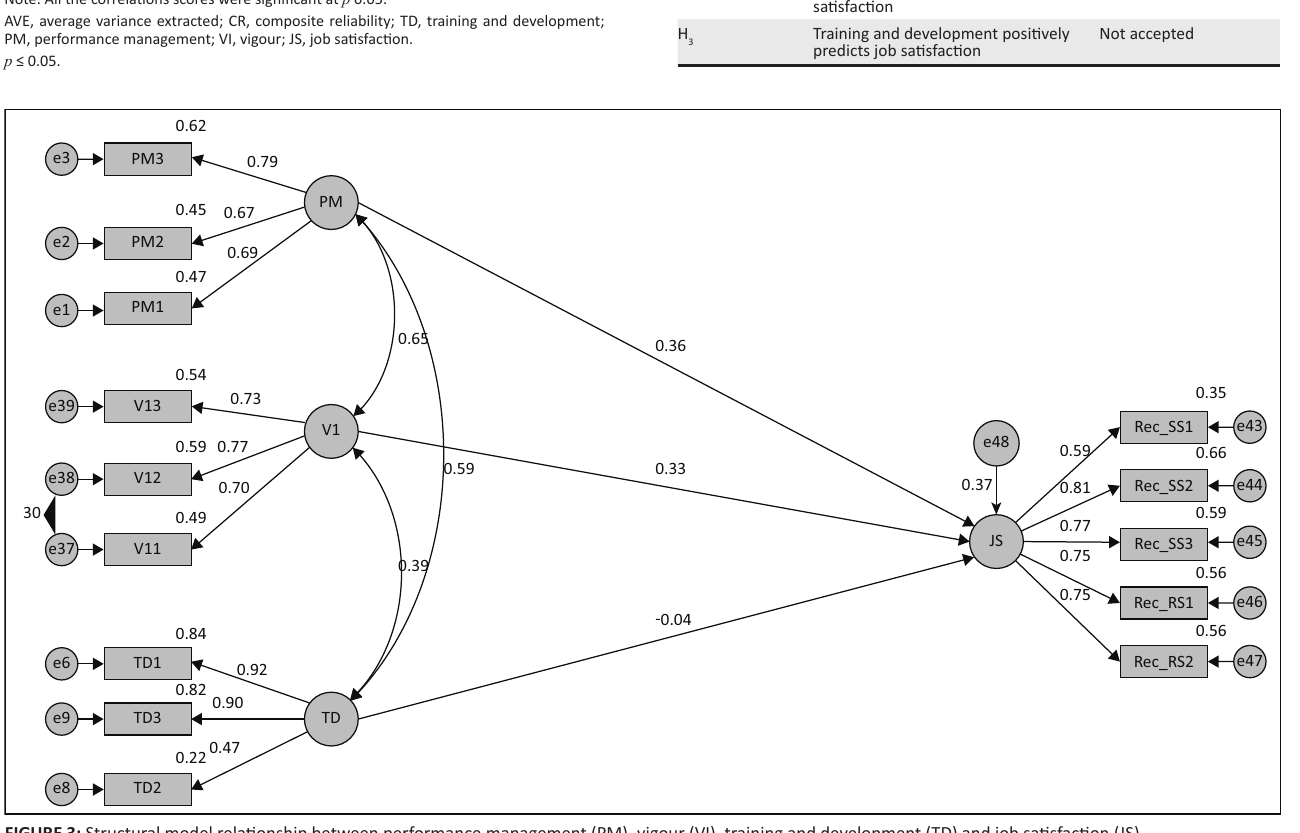
FIGURE 3: Structural model relationship between performance management (PM), vigour (VI), training and development (TD) and job satisfaction (JS).